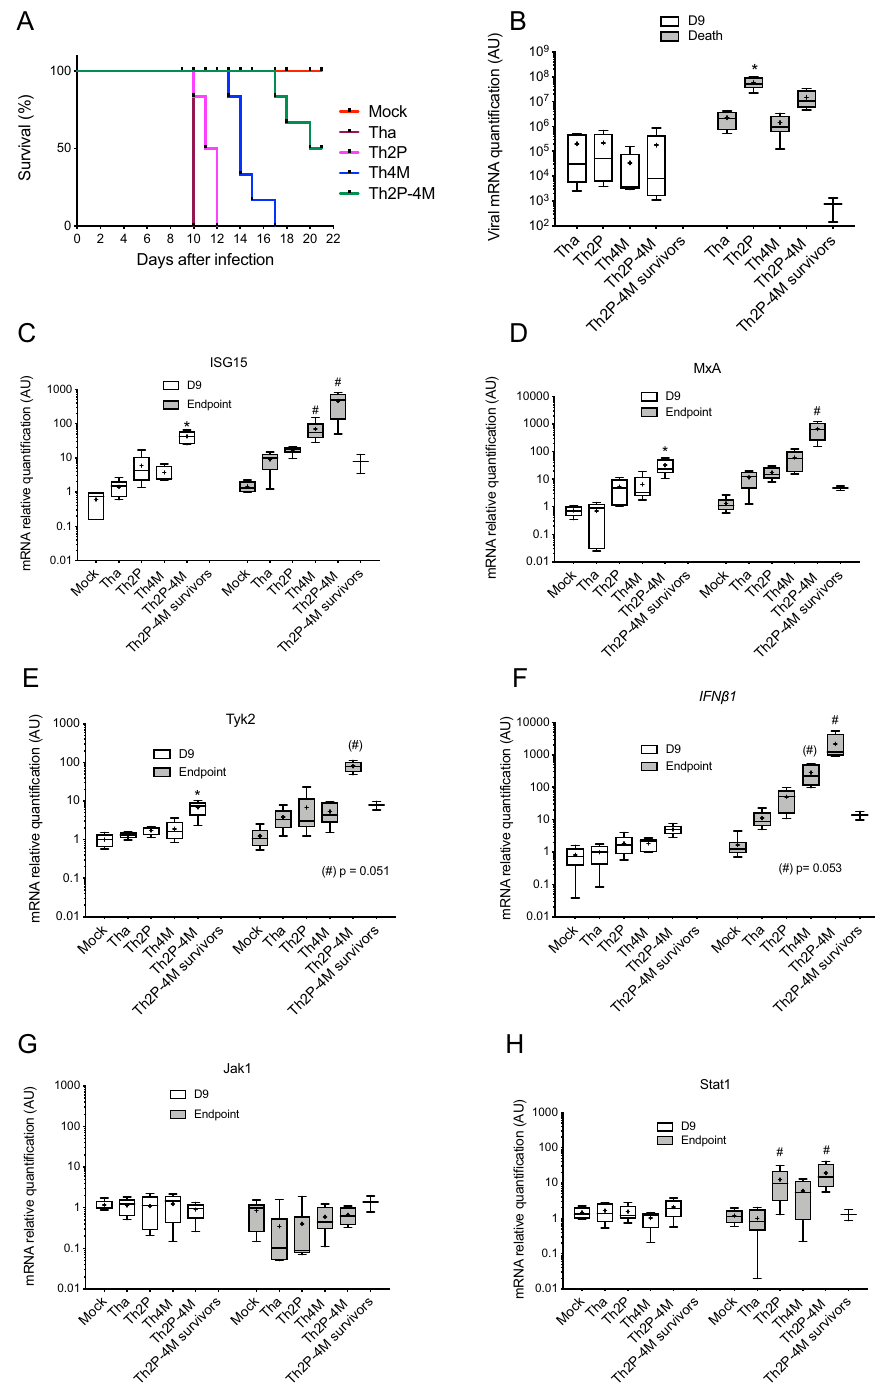
Figure 4. Mutated P and/or M proteins attenuate RABV virulence correlating with differing innate immune- response activation. Three-week-old BALB/c mice (6 per experiment) were infected intramuscularly with 1000 FFUs of Tha, Th2P, Th4M or Th2P-4M RABVs and monitored for 21 days. At the end of the experiment, 3 mice survived when infected with Th2P-4M, named Th2P-4M survivors. ( A ) The mice were sacrificed day 9 post- infection (denoted D9) or when late infection symptoms appeared (endpoint). mRNA, extracted from their brains, was subjected to RT–qPCR to analyze expression of the indicated genes, normalized to the GAPDH - reporter gene level in Mock-infected mice. RABV mRNA ( B ), and ISG15 ( C ), MxA ( D ), IFN β 1 ( E ), Tyk2 ( F ), Jak1 ( G ) and Stat1 ( H ) gene expression was measured. Results show means ± standard deviation (T-bars) expressed in arbitrary units (AU). (NA): non applicable; * p < 0.05 compared to Mock-infected D9 samples and # p < 0.05 compared to Mock-infected End-point samples. Th2P-4Ms * : Th2P-4M